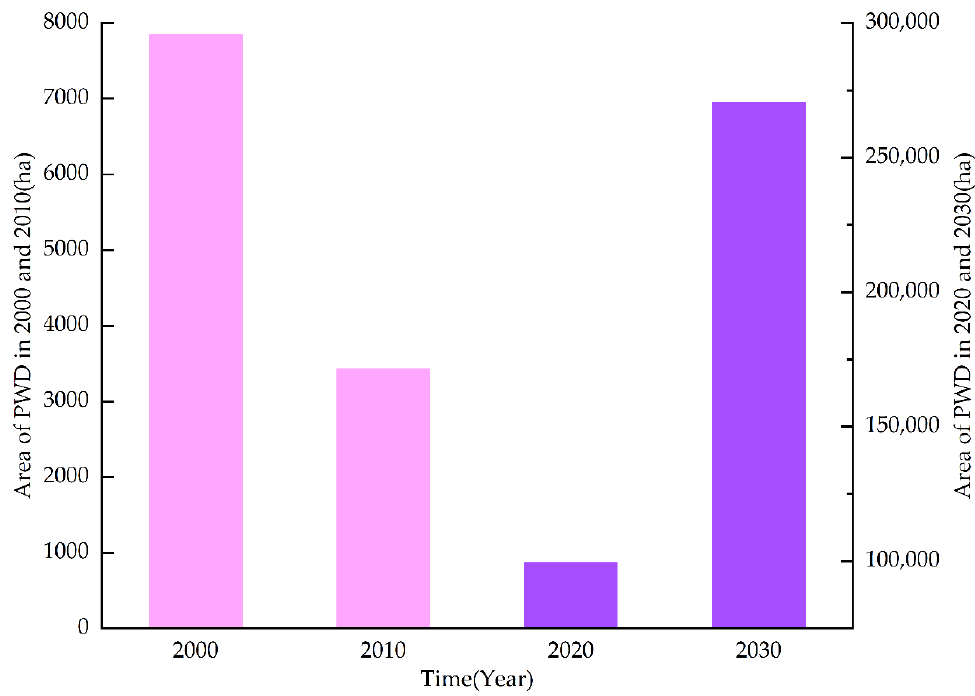
Figure 5. The annual occurrence area of PWD in Anhui Province.